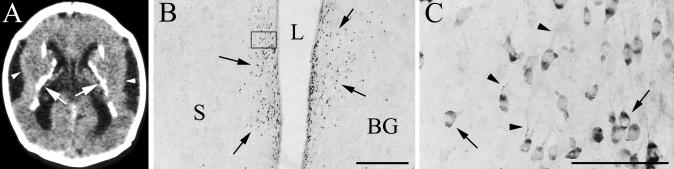
Congenital LCMV Infection of Humans Induces Periventricular CalcificationsThe neonatal rat model demonstrates that periventricular neurons are selectively vulnerable to infection with LCMV.(A) Head CT scan from an infant with congenital LCMV infection. The scan reveals microencephaly and prominent periventricular calcifications (arrows). In addition, this scan reveals an abnormal cortical gyral pattern (arrowheads), suggestive of disturbed cortical neuronal migration.(B) Horizontal section (50-μm-thick) through a 49-d-old rat brain immunohistochemically stained for LCMV. The rat was inoculated as a neonate with LCMV. Infection is localized to the periventricular region (arrows). L = lateral ventricle, S = septum, BG = basal ganglia.(C) Higher magnification of the boxed area in (B) shows that the infected cells are neuronal in morphology. Viral antigen is present in neuronal cell bodies (arrows) and neurites (arrowheads).Magnification bars represent 500 um in (B) and 100 um in (C).